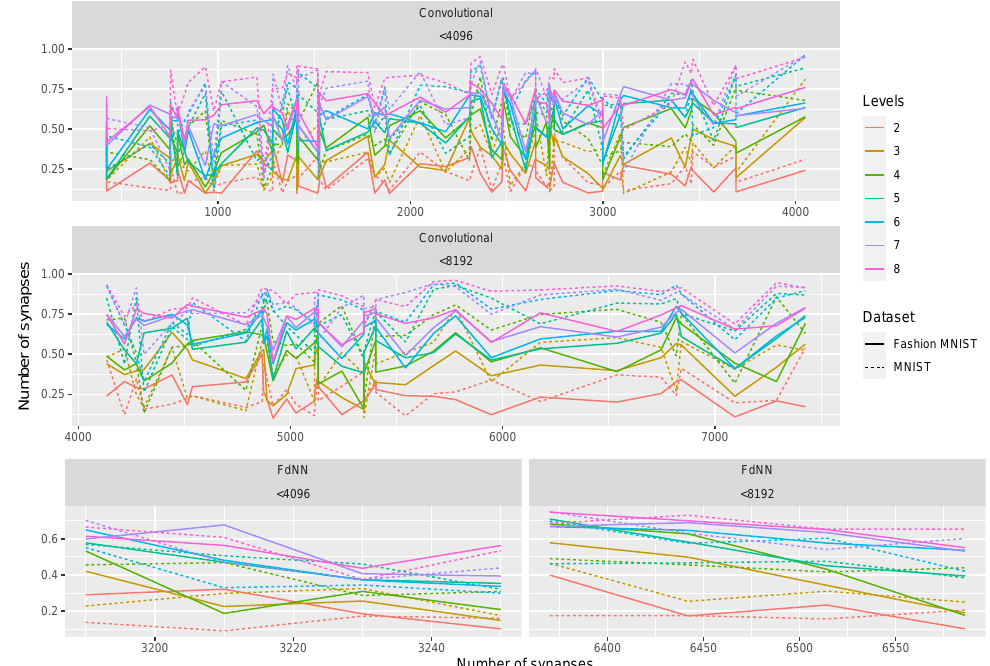
Figure 8. Categorical accuracy obtained for the MNIST and Fashion MNIST datasets in training and test for both FdNN and CNN with different number of synapses categorized in two groups: less than 4096 and between 4096 and 8192 synapses for each experiment using quantization levels between 2 and